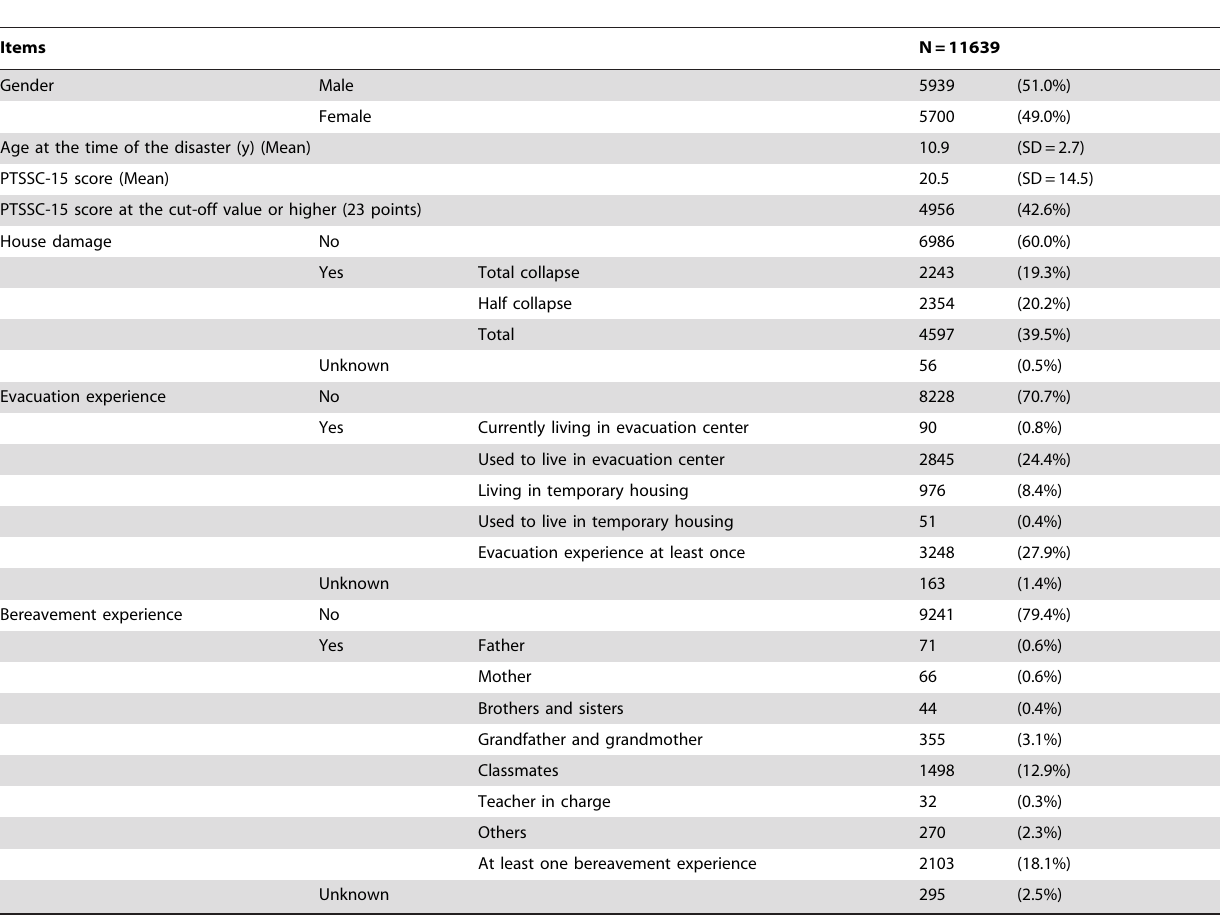
Table 1. Characteristics of children who experienced the 2011 Japan Earthquake and